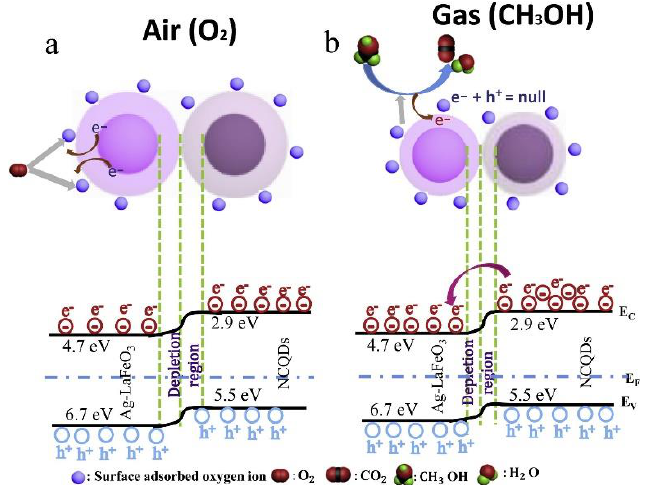
Figure 18. Mechanism of methanol detection by N-doped carbon QD/Ag-LaFeO 3 gas sensor in ( a ) air and ( b ) CH 3 OH gas [133].